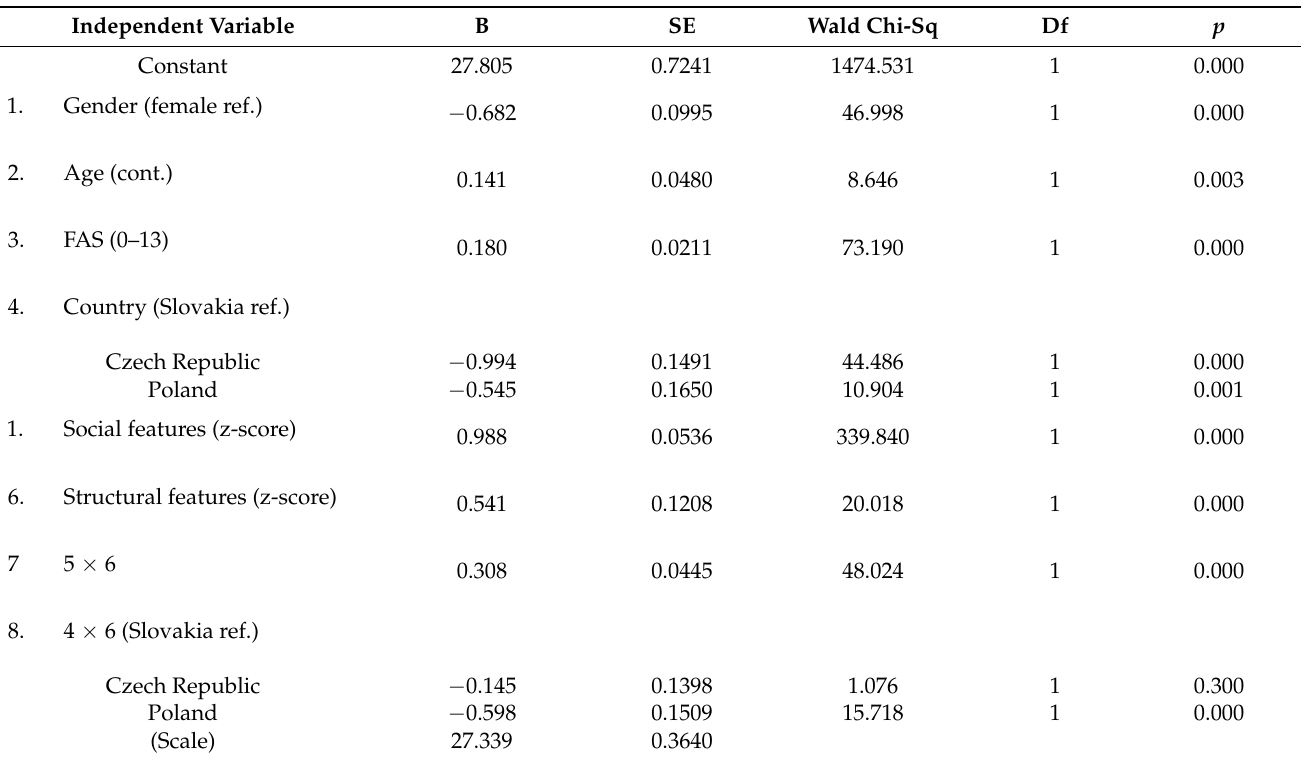
Table 6. Generalised linear model (GLMZ) for HLSAC